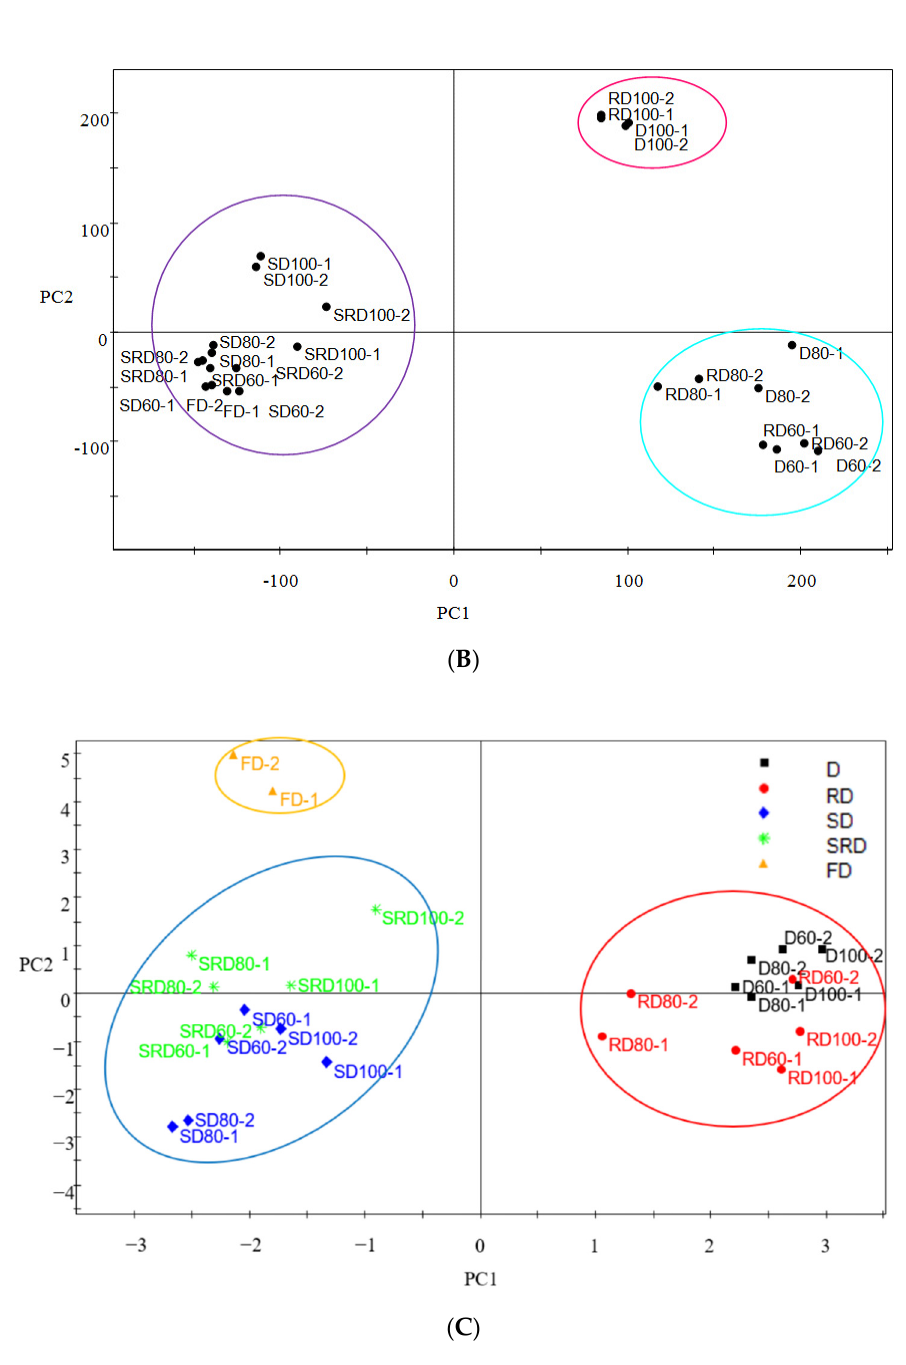
Figure 5. ( A ) Heat map depicting the results of hierarchical cluster analysis using the Euclidean distance method, and ( B ) PCA score plots and ( C ) PLS-DA data obtained from Dendrobium catenatum leaves after exposure to various processing methods.